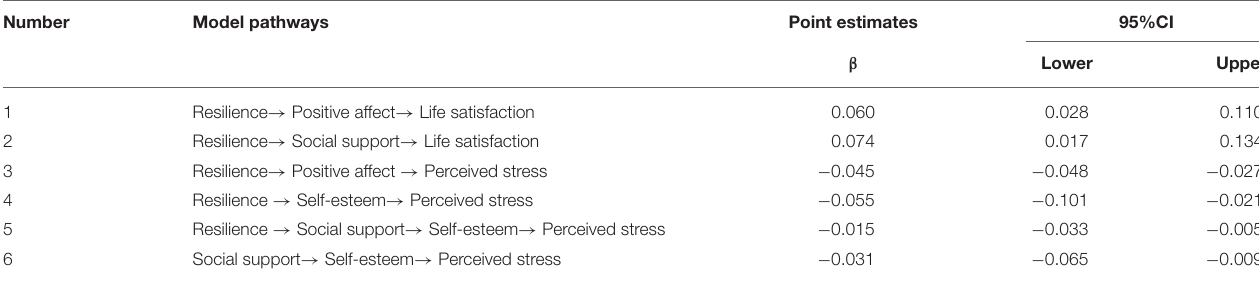
TABLE 4 | The indirect effects of the final mediational model after controlling gender and age.